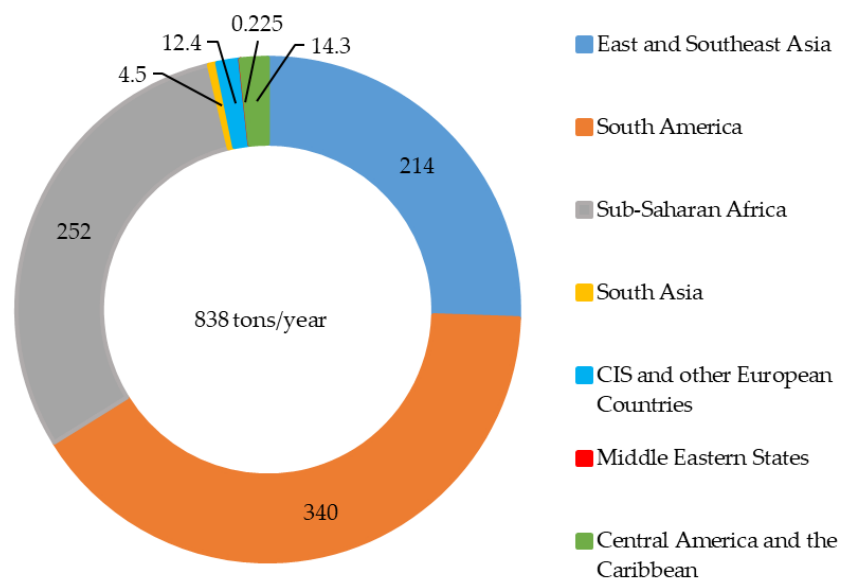
Figure 1. Regional results of global Hg emissions into air from the ASGM sources. Each value represents tons/year [4].